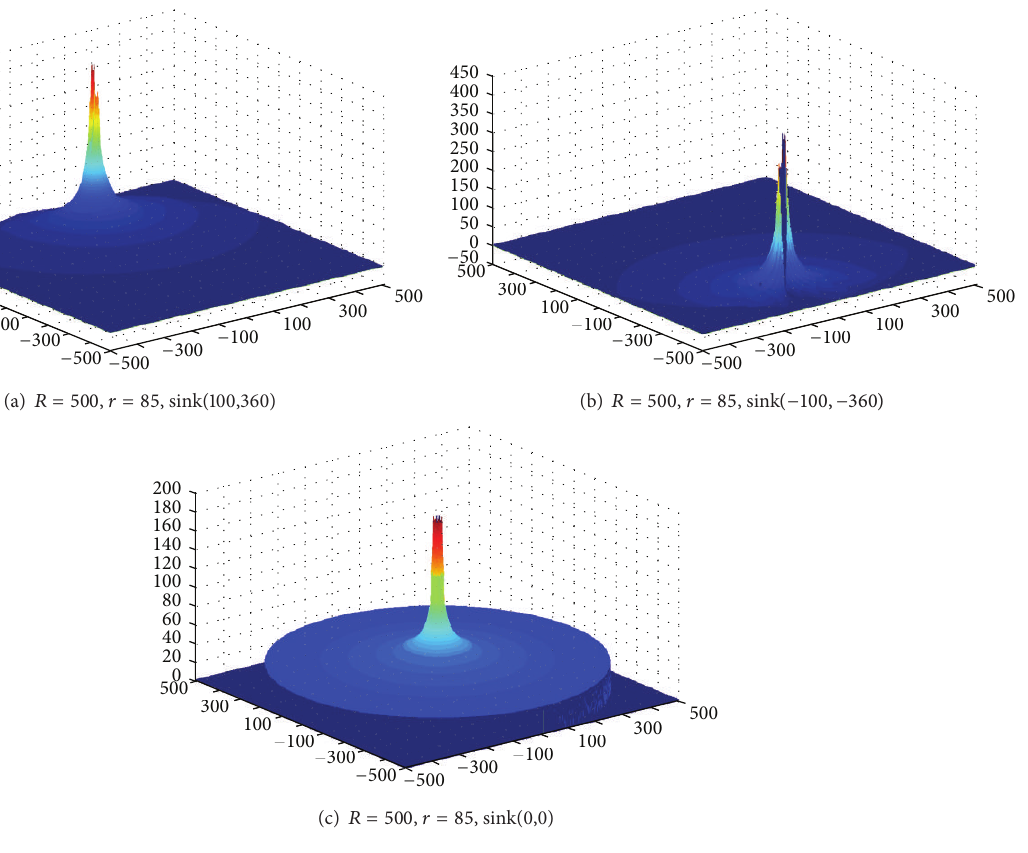
Figure 3: Data load of network.